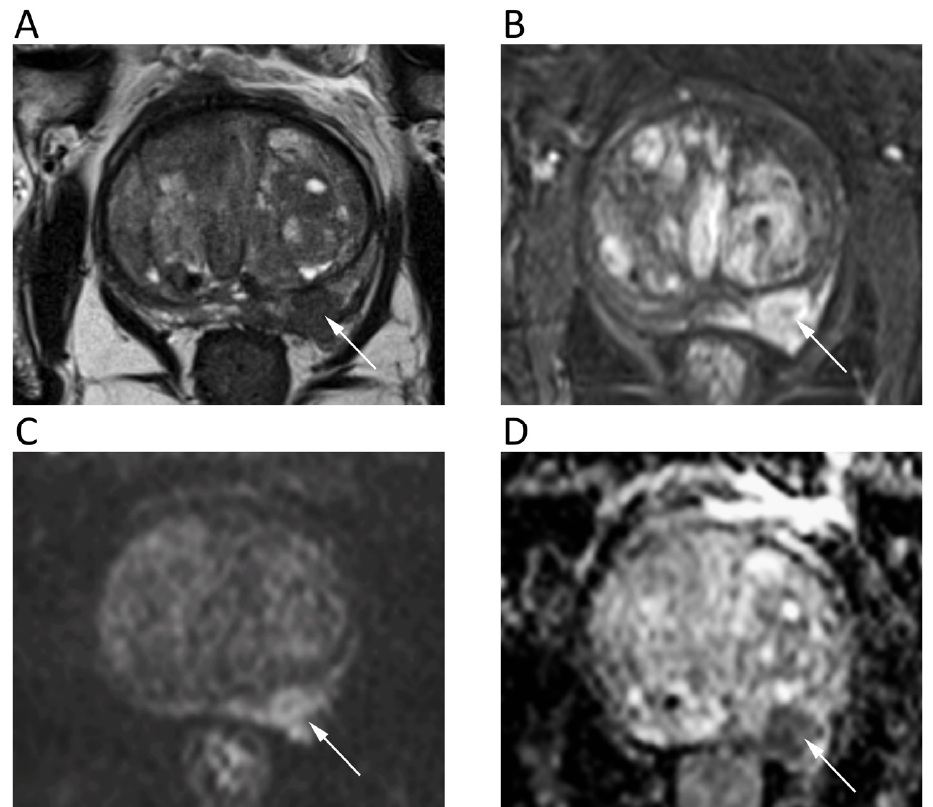
Figure 10. A 68-year-old male patient with prostate cancer. Axial T2w ( A ) and post-contrast fat-suppressed T1w ( B ) images show a hypointense nodule in the left peripheral zone (arrows) with high signal intensity on b = 1000 DWI image ( C ) and restricted pattern of diffusion on the corresponding ADC map ( D ).